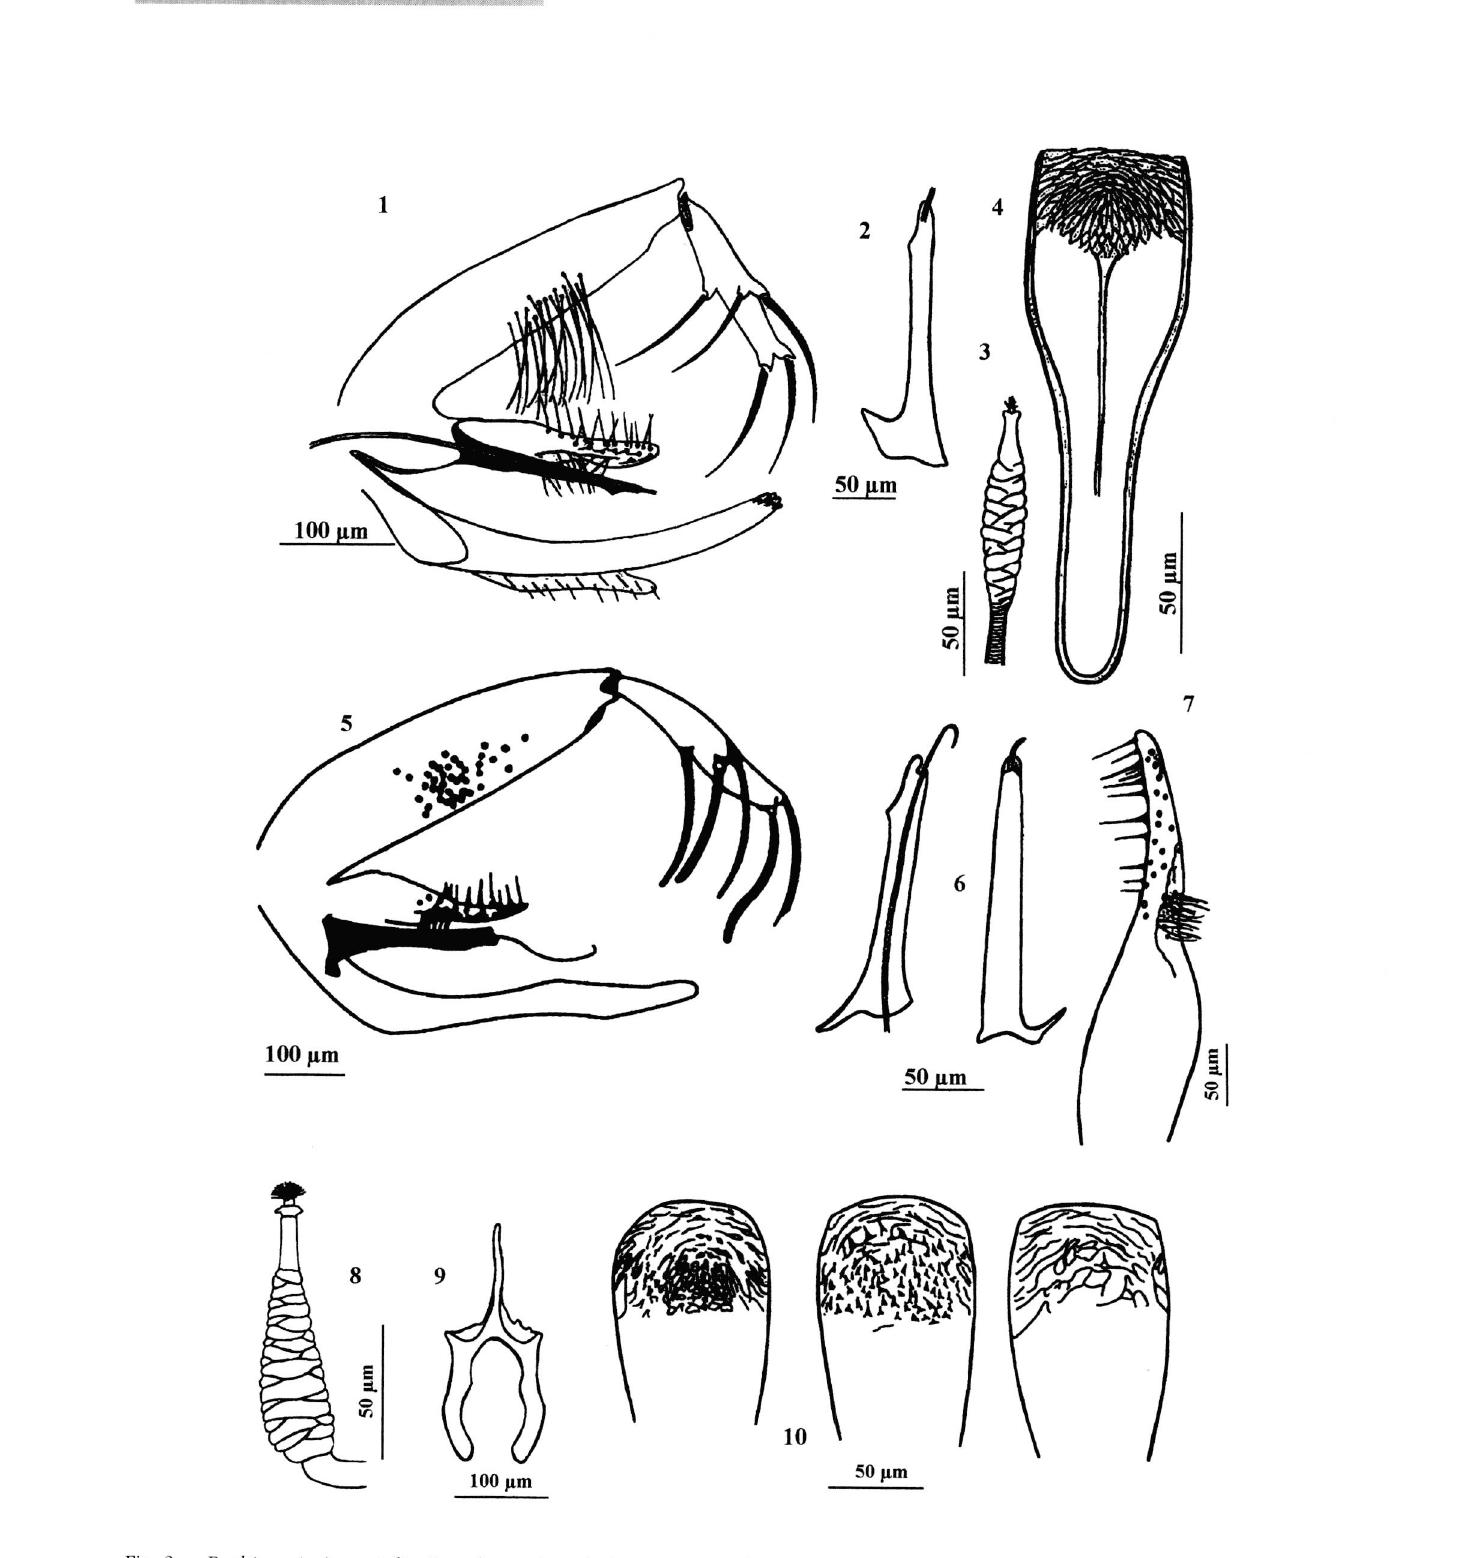
Fig. 2. - P. chinensis. 1. genitalia; 2. aedeagus lateral view; 3, spermatheca; 4, pharynx (after Theodor, 1958); P. sichanensis. 5, genitalia; 6, aedeagus, lateral wiew and ventral view; 7, paramere showing the short hairs in the middle of lateral side; 8, spermatheca; 9, furca; 10, pharynx viewed at three different focal depths for the same specimen (after Leng & Yin, 1983).